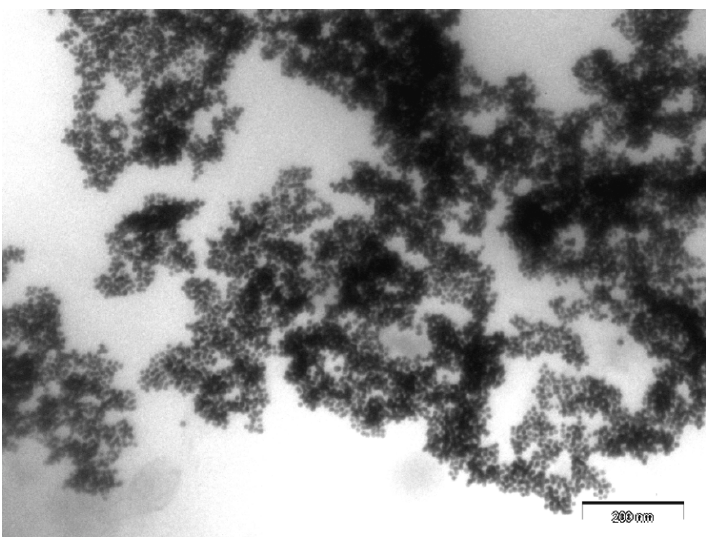
Figure 2. TEM image (100,000 × magnification) of aggregates of 1 @AuNPs.